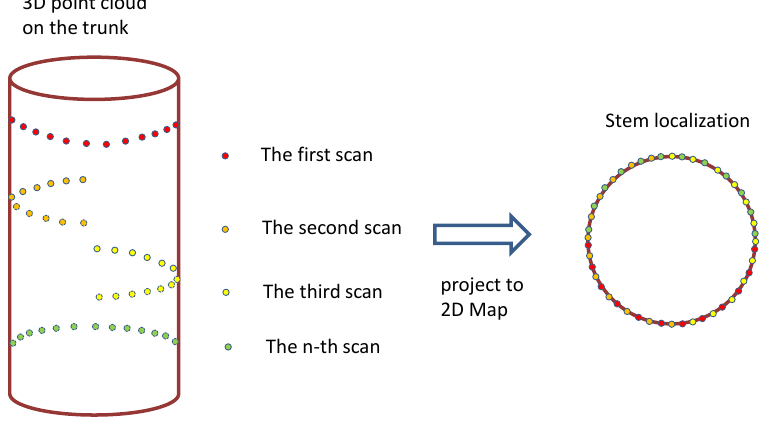
Figure 3. Illustration of projecting a 3D point cloud on the trunk onto a 2D map for stem location [14].